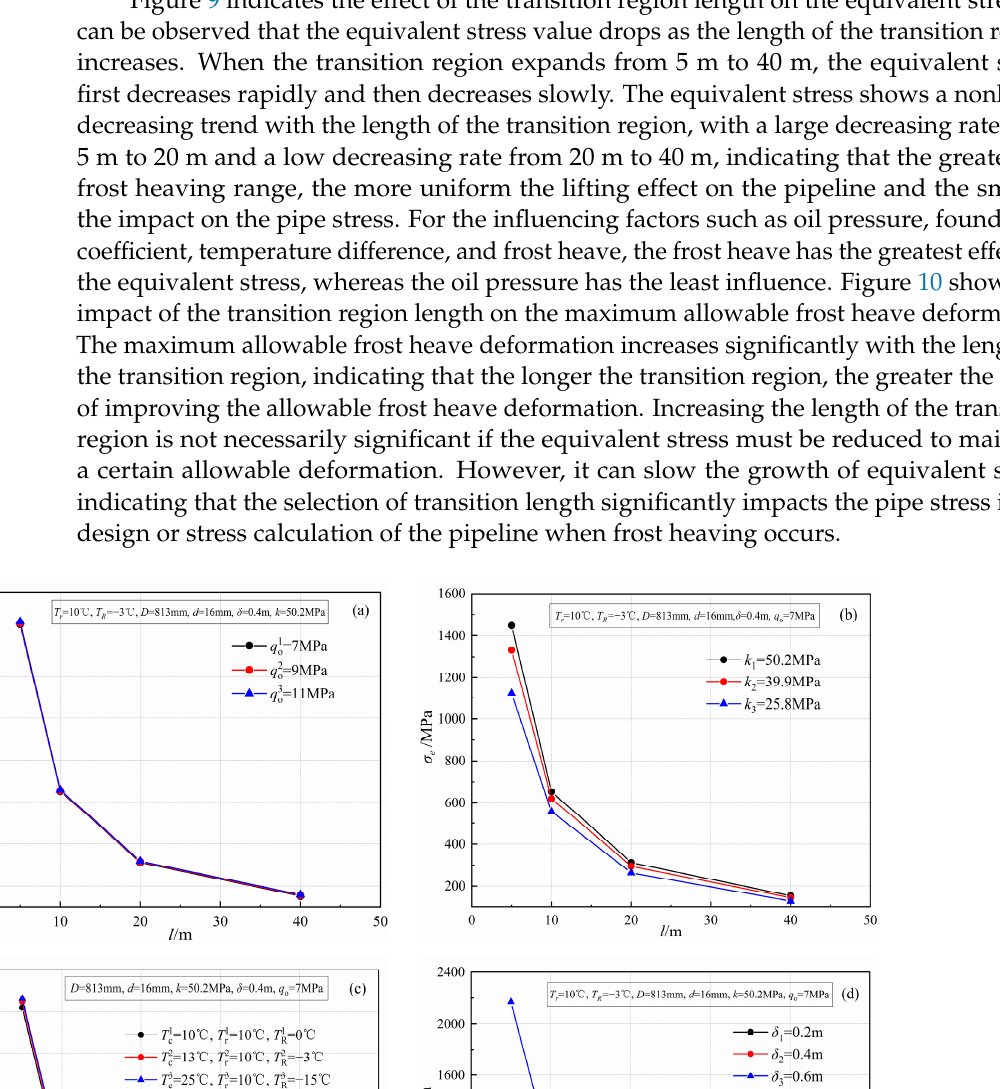
Figure 10. Effect of transition length on maximum allowable frost heave deformation. 3.6. Pipe Size Analyzing and comparing the following conditions: the same frost heave (